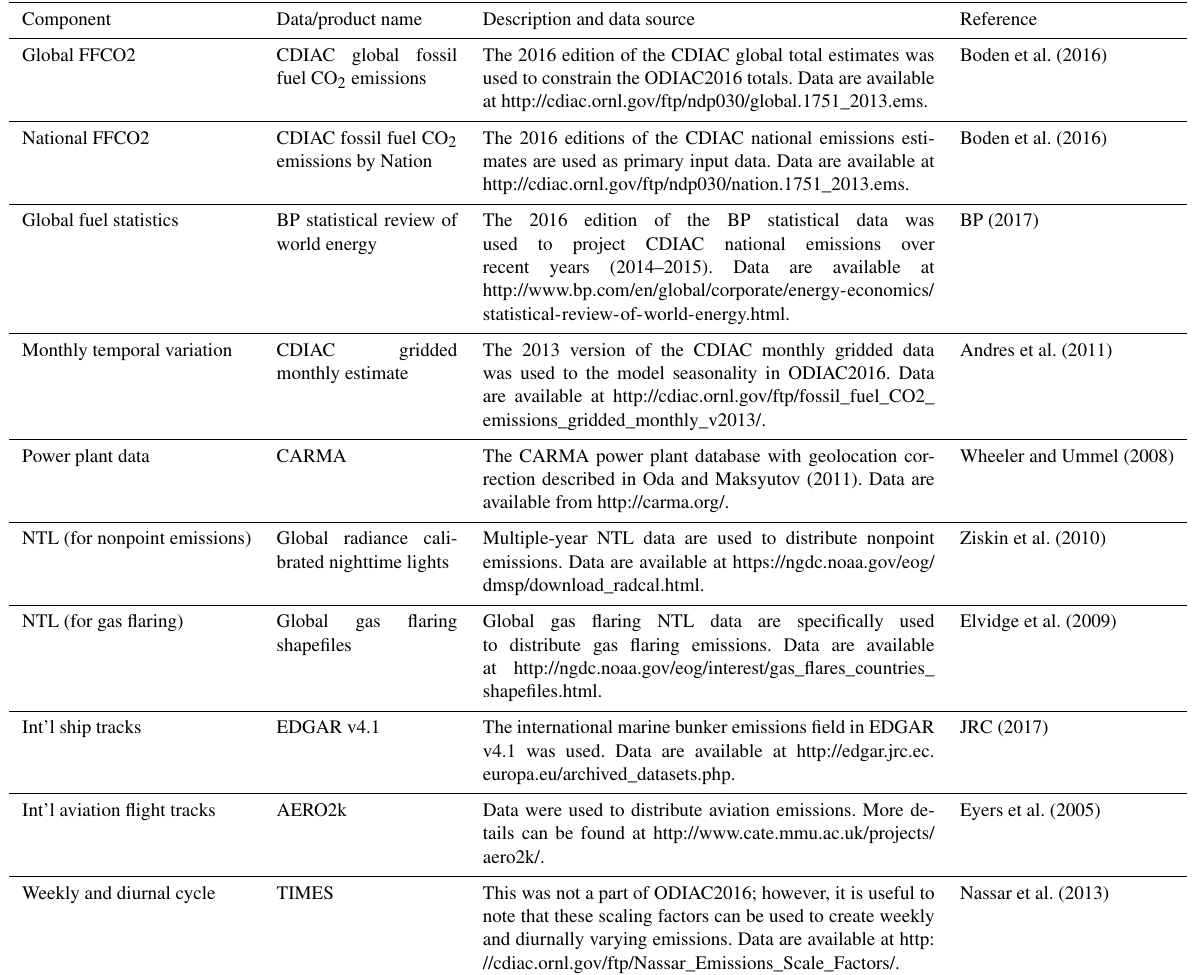
Table A1. A list of components in ODIAC2016 and data used in the